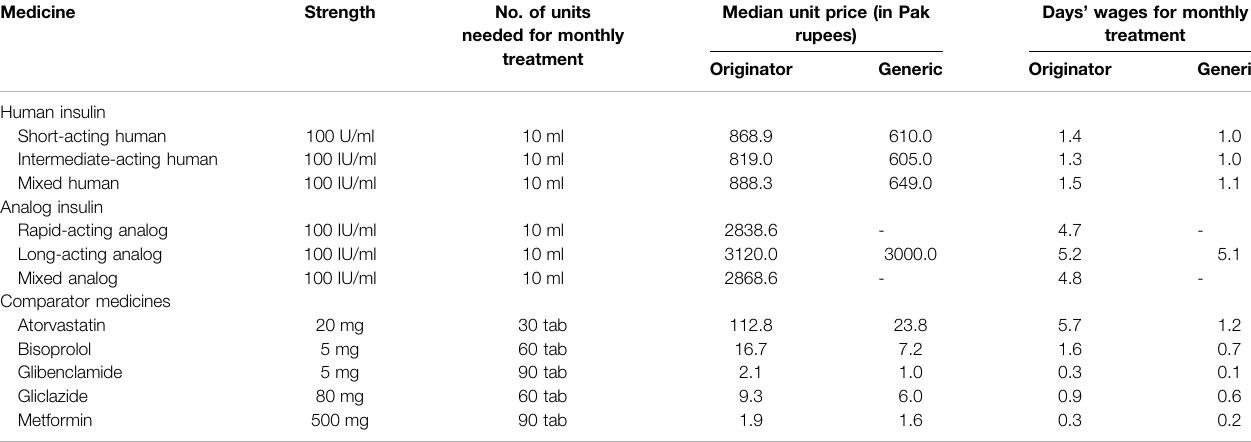
TABLE 5 | Median patient prices and affordability of insulin and comparator medicines in the private sector.